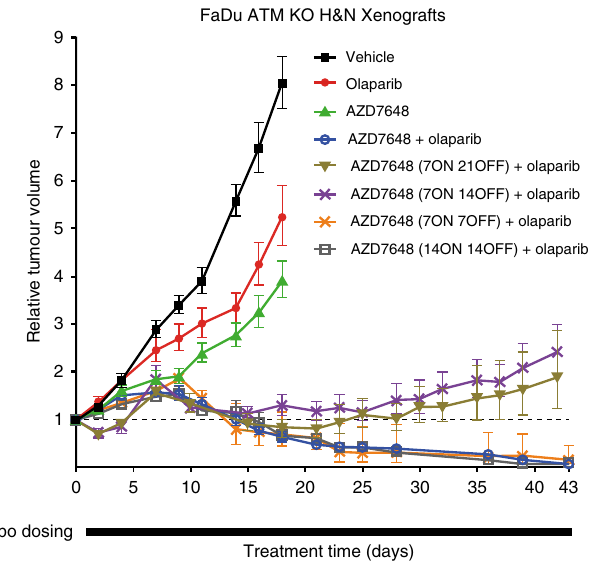
Fig. 8 Anti-tumour effect of intermittent schedules of AZD7648 in combination with olaparib in FaDu ATM KO xenografts. Discontinuous schedules of AZD7648 increase the anti-tumour effects of olaparib in FaDu ATM KO xenografts. Doses: AZD7648 75mg kg − 1 bid; olaparib 100 mg kg − 1 qd, dosed 1h after AZD7648 dose (SCID mice, vehicle n = 13, olaparib n = 10, AZD7648 n = 8, continuous and 7ON 21OFF n = 6, 7ON 14OFF n = 7, 7ON 7OFF and 14ON 14OFF n = 5, geometric mean ±SEM). Corresponding mouse bodyweights and statistical analysis can be found in Supplementary Fig. 2G, Supplementary Table 3D. To assess tumour growth inhibition, one- tailed, two-sample, t -test with unequal variances was used and for tumour regression, one sample t -test